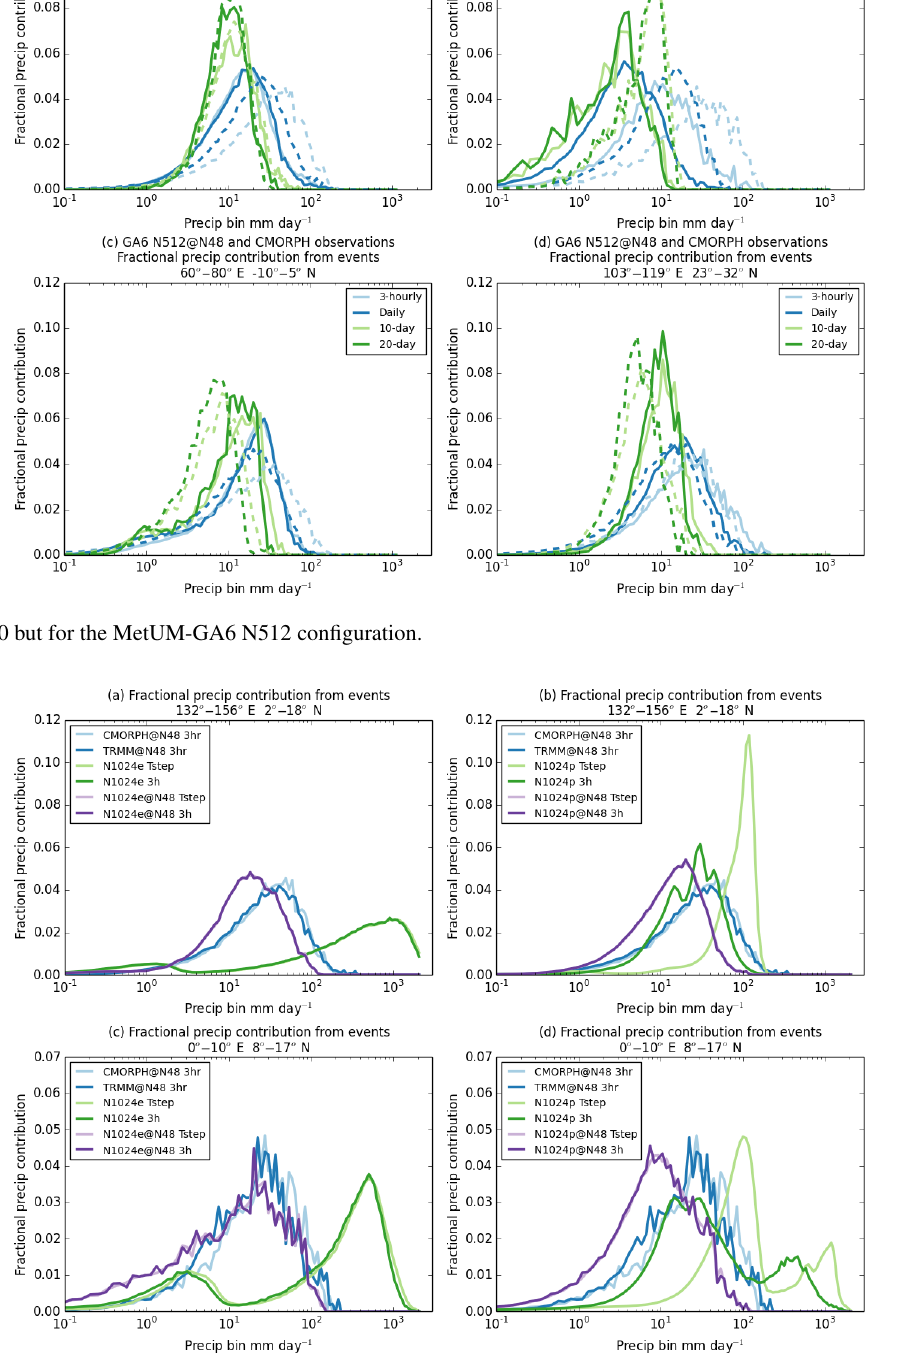
Figure 13. Spectra of time step (5min) and 3-hourly rainfall contributions, at native resolution and averaged to the N48 grid, from (left) MetUM-GA6 N1024e and (right) N1024p configurations, averaged over (top) the “WP” domain and (bottom) the “WA”